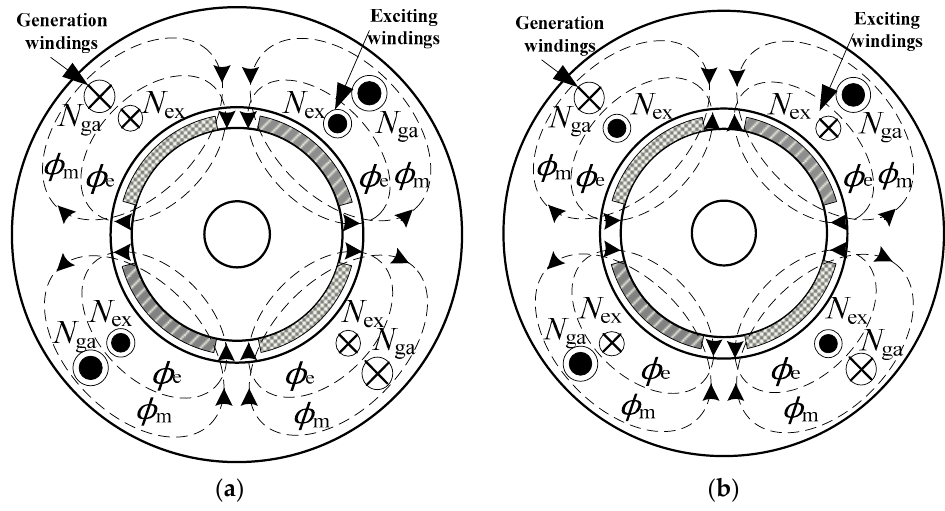
Figure 4. The excitation principle of HEBPMG. ( a ) The synthesis of magnetic field is compensated by excitation magnetic field; ( b ) The synthesis of magnetic field impaired by excitation magnetic field.